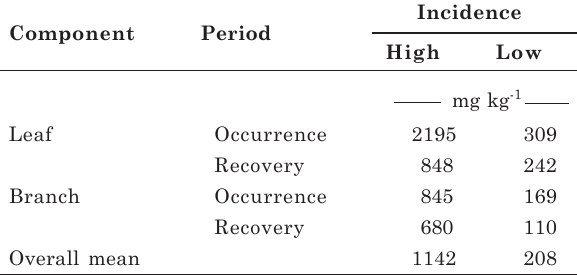
Table 7. Mn contents in leaves and branches (clone 386) collected in areas with high and low incidence of ESBVRD in the period of large occurrence of the anomaly (July 23, 2009) and in the recovery period (October 8, 2009) grown in a Neossolo Flúvico (Fluvisol) on the Incidence Component Period High Low mg kg -1 Leaf Occurrence 2195